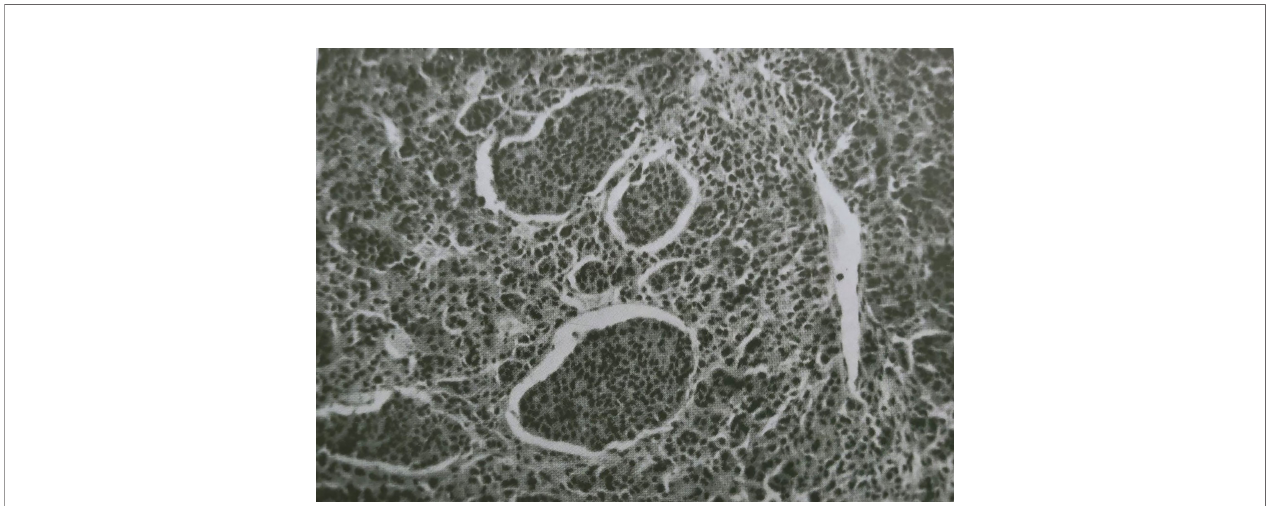
FIGURE 2 | Malignant choroidal melanoma showing masses of neoplastic epithelioid cells invading a tumor vessel lumen. (Reproduced with permission from Prof. Gallenga P.E., Rass. Ital. Ottal.; published by Clinica oculistica dell ’ Università di Torino,